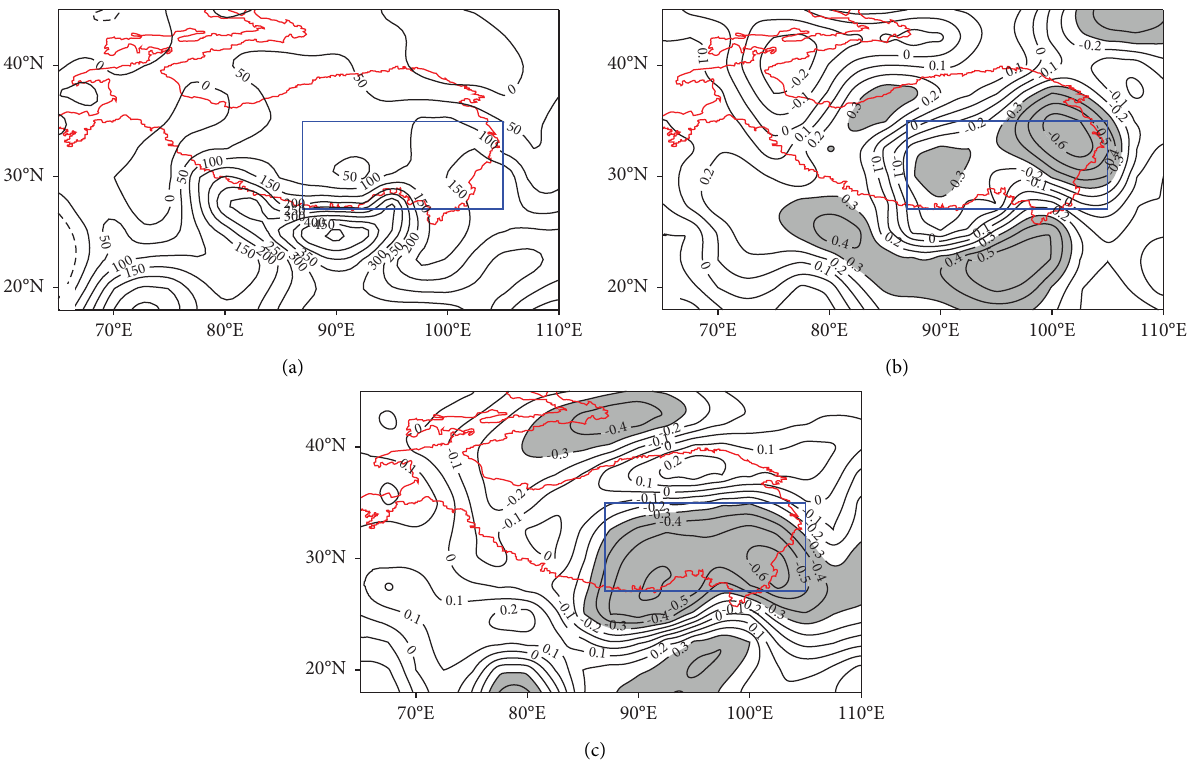
Figure 1: Spatial distribution of average atmospheric heat source of the whole layer in summer 1981–2020 (a) unit: w/m 2 and the corresponding correlation coefcient between the EASWJ index (b) and the EASM index (c) with heat source (blue area: 87.5–105 ° E, 27.5–35 ° N).